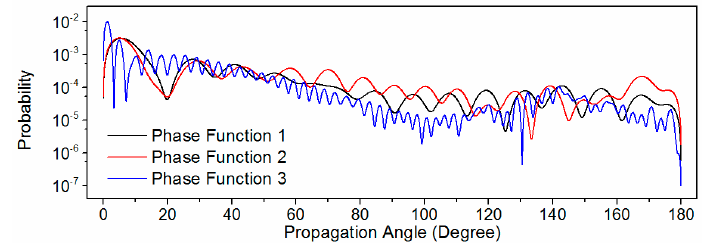
Figure 2. Phase functions used in this study.